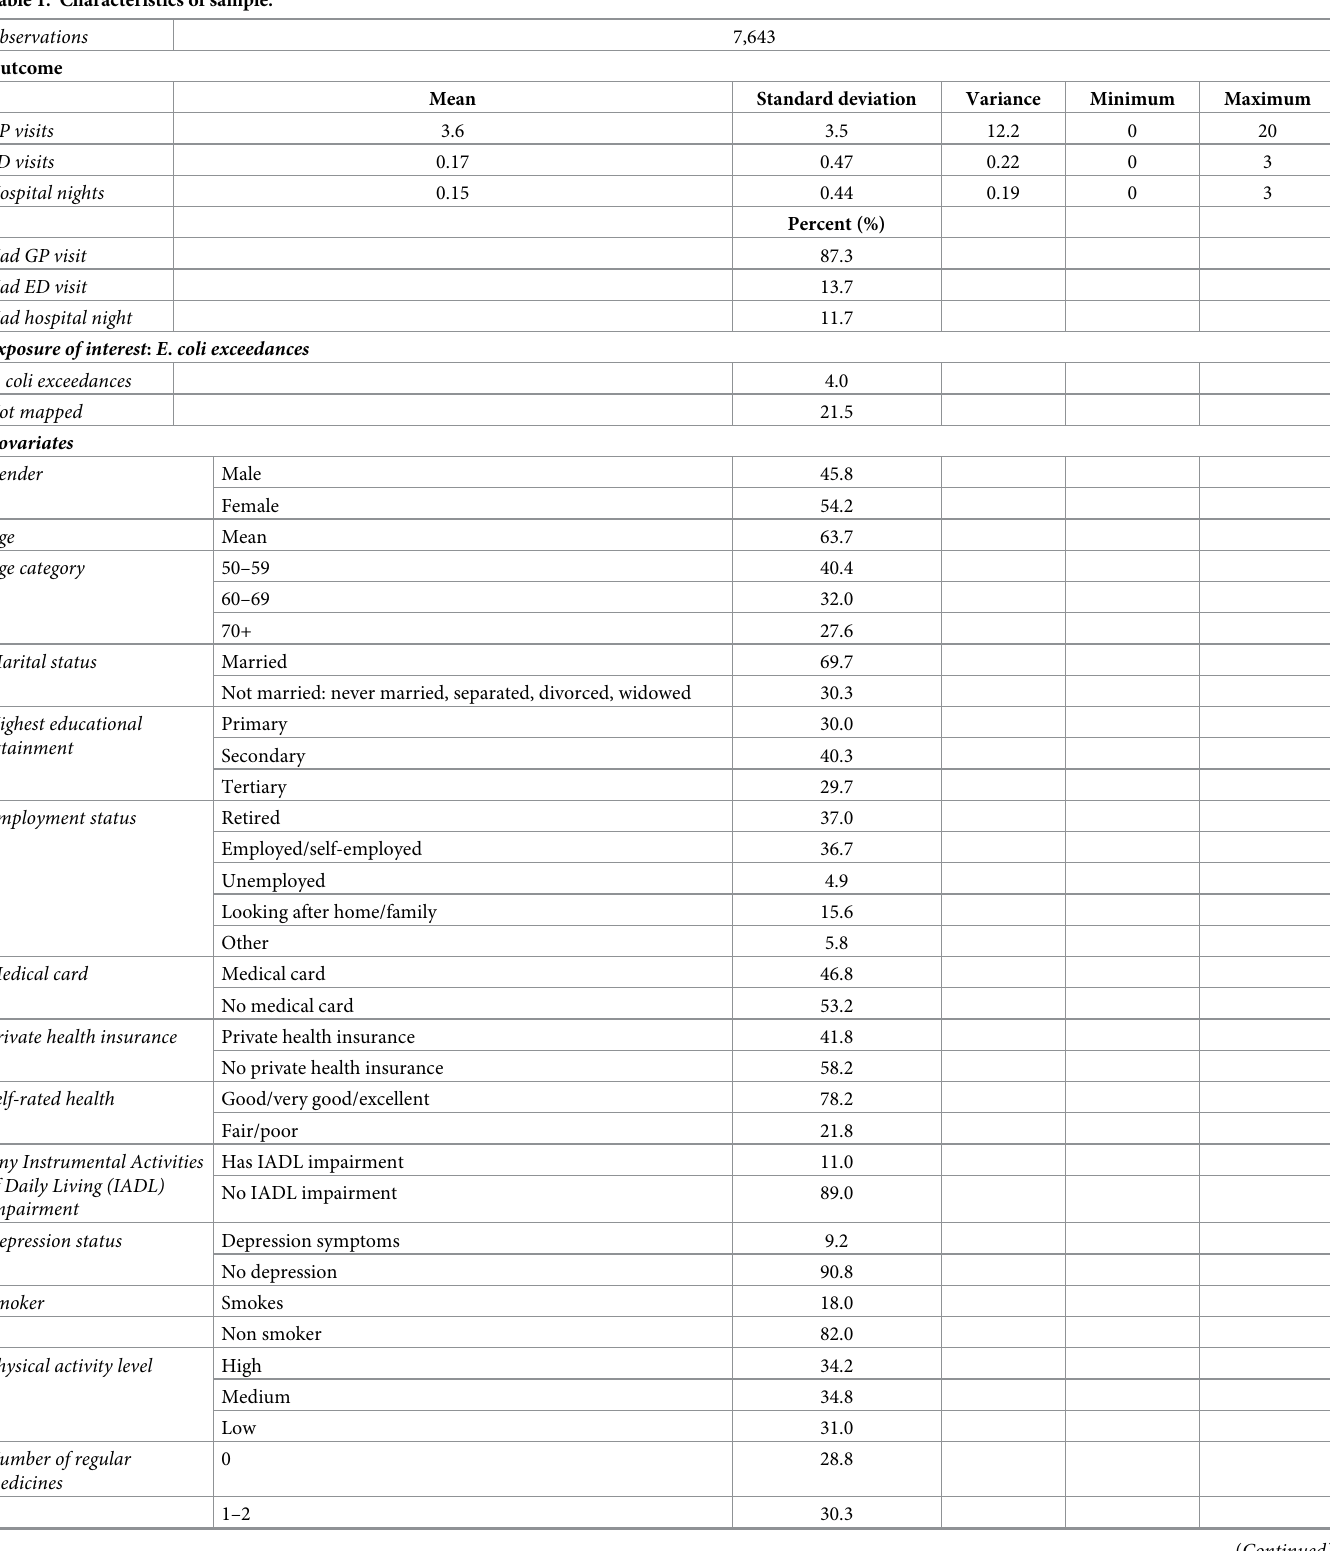
Table 1. Characteristics of